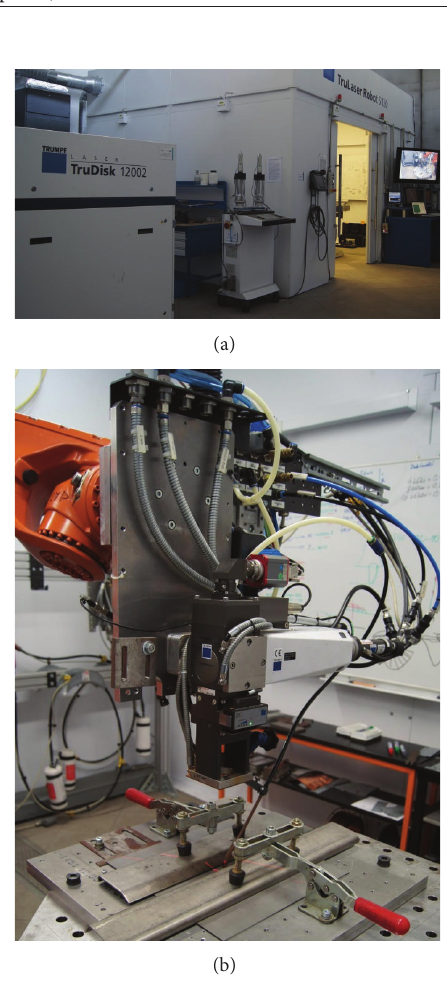
Figure1:DisklaserTruDisk12002integratedwithrobotisedstation. Main view of station (a) and CFO head for laser beam keyhole welding